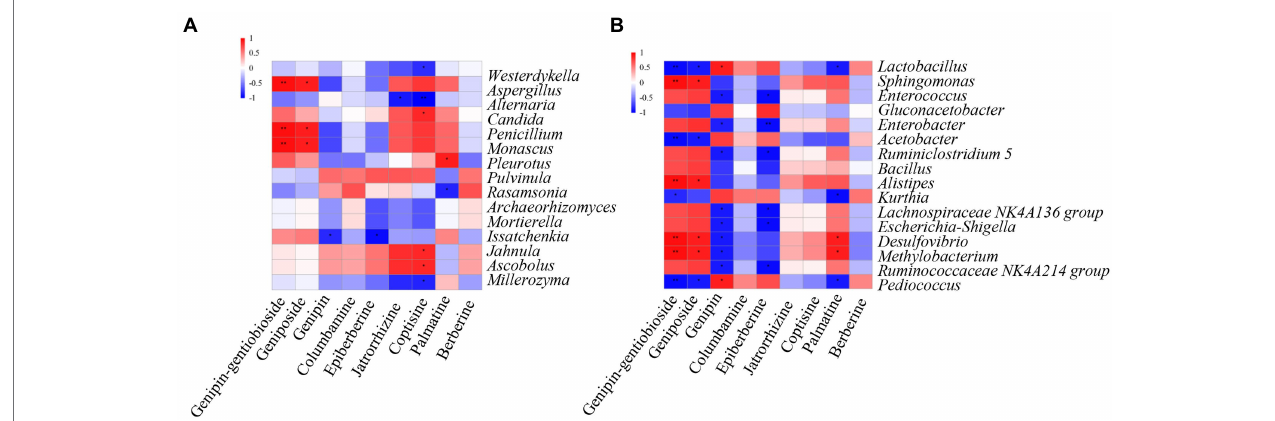
FIGURE 5 | Spearman correlation heatmap between dominant (A) fungal and (B) bacterial genera and chemical compound during LZF fermentation. The X and Y axes are chemical compound and abundant fungal and bacterial genera, respectively. The correlation coefficient ( R ) appears in different colors. The left side of the legend is the color range of different R values. The red color represents positive correlation and the blue color represents negative correlation. Significant values are shown as: * p > 0.01; ** p >